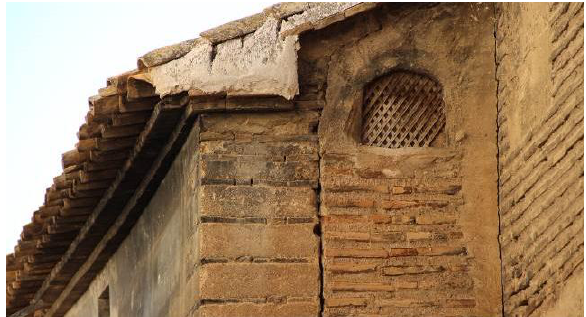
Figure 14. Rammed earth corner supplemented with bricks (Source: authors).